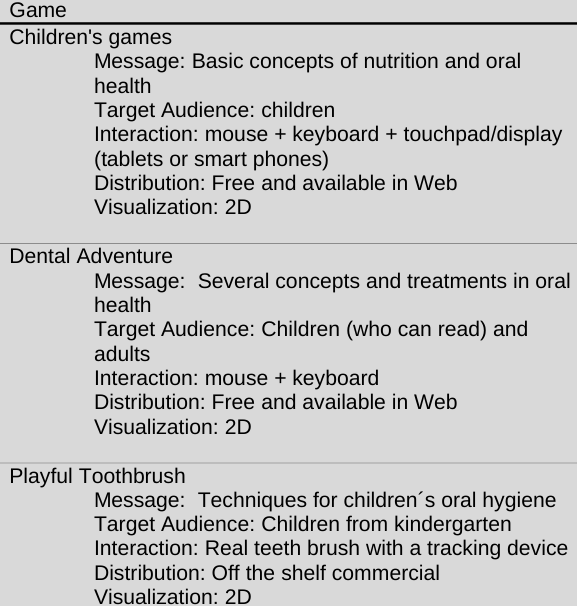
C HARACTERISTICS OF SERIOUS GAMES RELATED TO DENTISTRY FOUND IN THE LITERATURE .